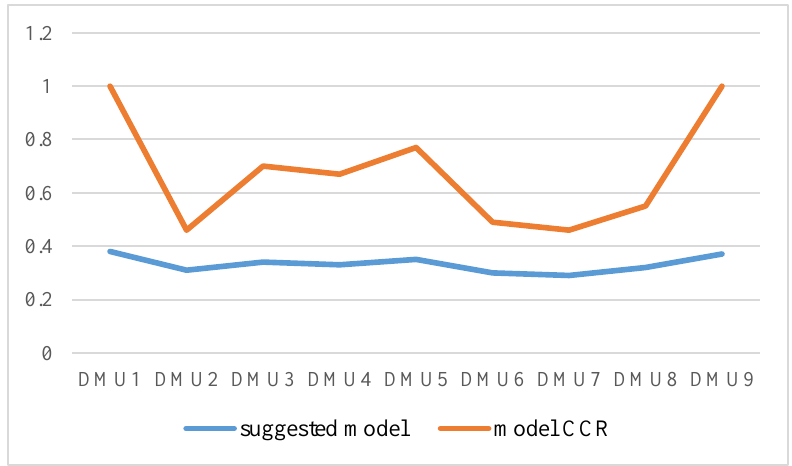
Fig. 5. Comparison of efficiency score of the proposed model and